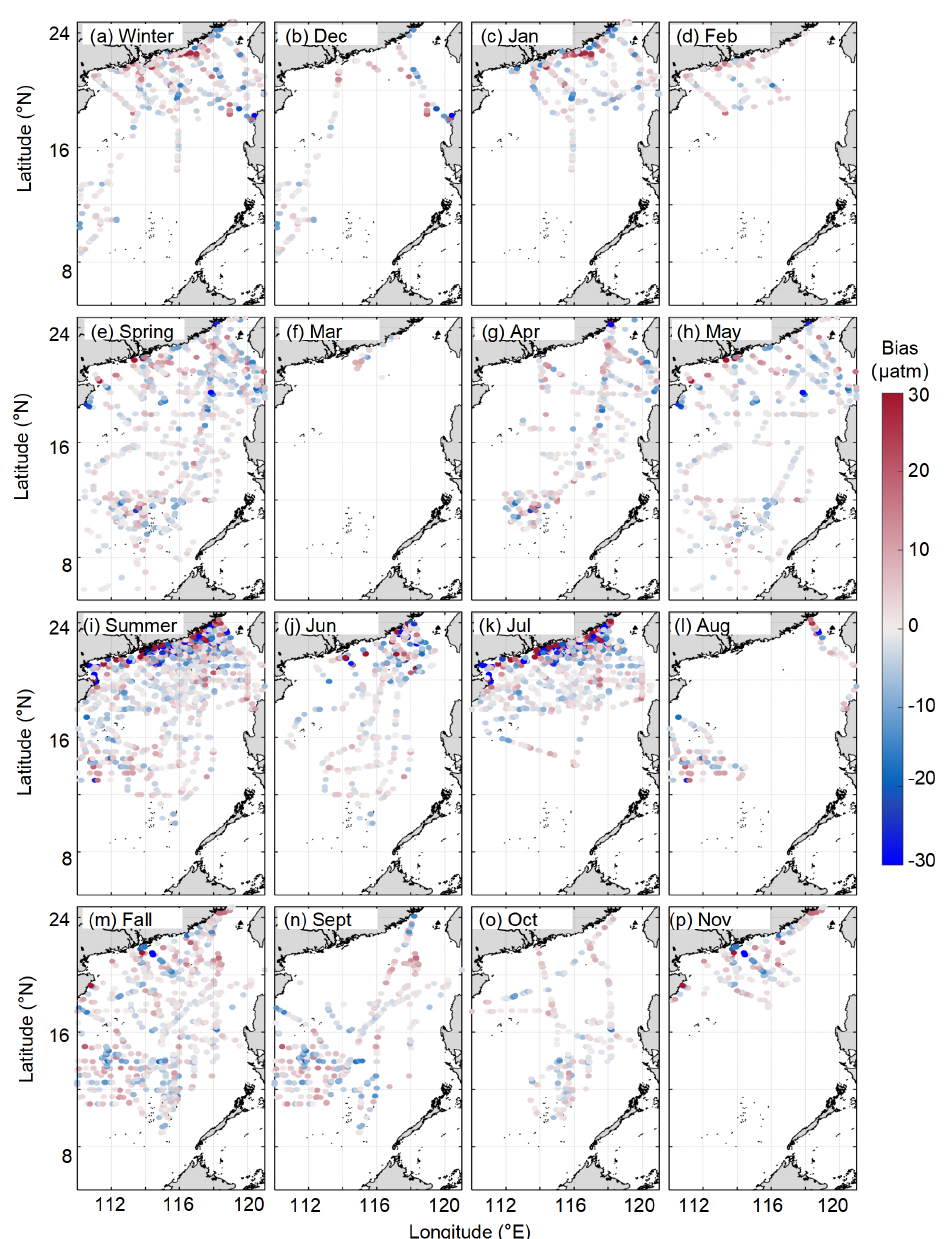
Figure 8. Differences between the reconstructed and in situ p CO 2 data, both seasonally and monthly, for the testing set, including (a) winter, (b) December, (c) January, (d) February, (e) spring, (f) March, (g) April, (h) May, (i) summer, (j) June, (k) July, (l) August, (m) fall, (n) September, (o) October, and (p)